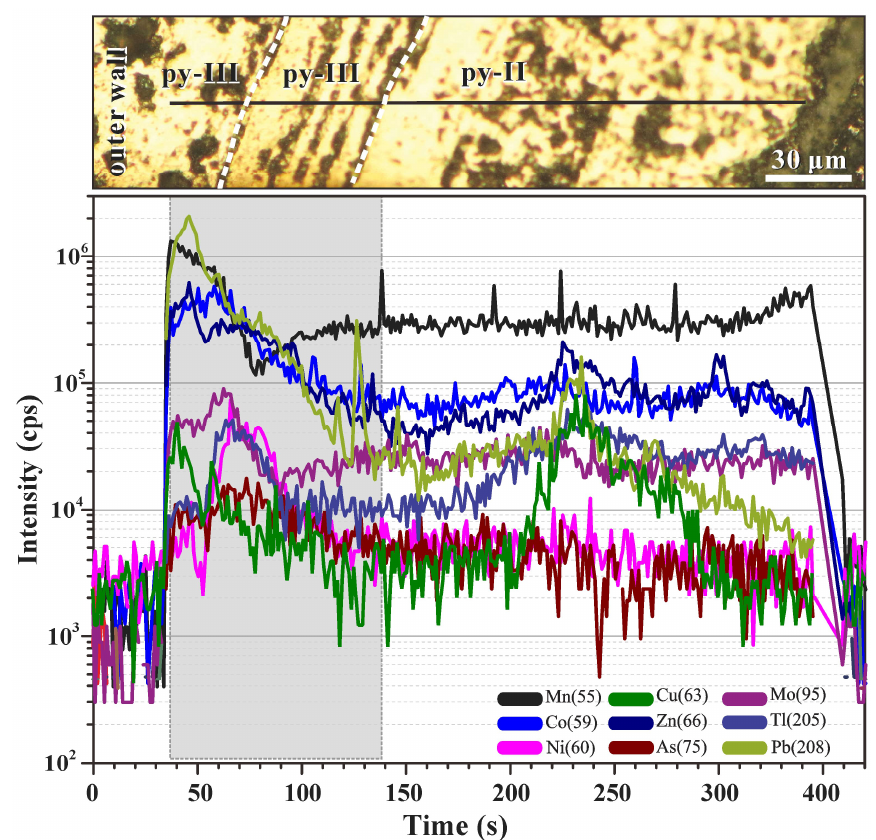
Figure 5. Signal sequence of a line scan analysis of colloform pyrite III and subhedral pyrite II in sample 17A-TVG9. The mass spectrum of colloform pyrite III is marked by high trace element concentrations (Mn, Pb, Cu, Zn, Co, and Mo) that generally decrease towards the more homogeneous subhedral pyrite II.